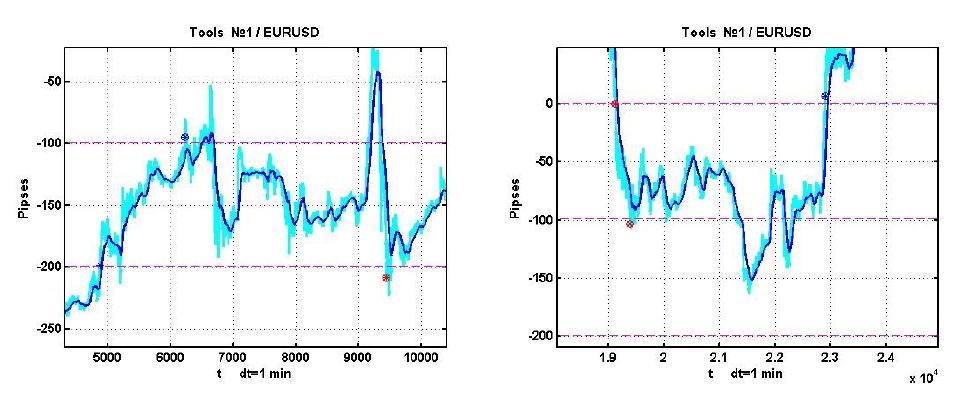
Figure 3. Examples of positive outcomes of management decisions.